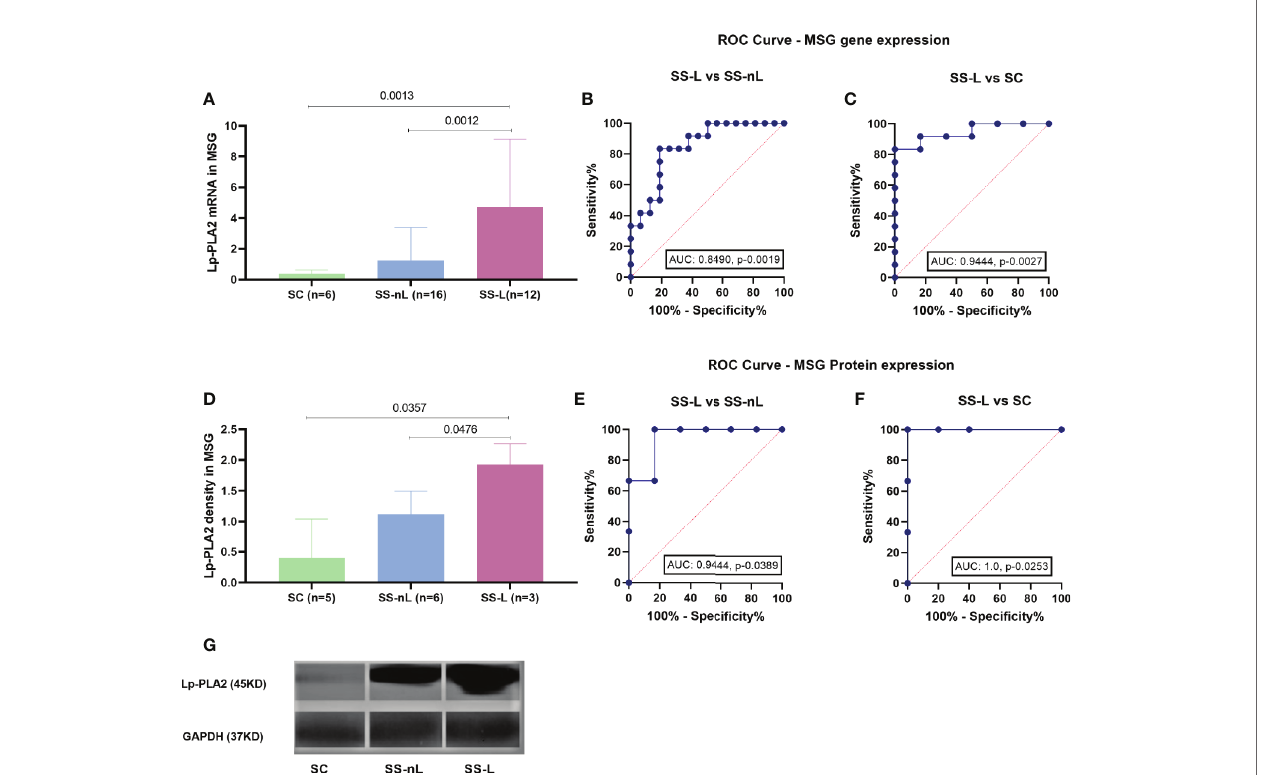
FIGURE 2 | Lp-PLA2 (encoded by the PLA2G7 gene) mRNA expression (measured by real-time PCR) and protein density (tested by Western blot) in MSG tissues of our study participants and ROC curve analysis for both methods. (A) PLA2G7 gene expression was signi fi cantly increased in SS-L patients compared to both SS- nL patients and SC (p-values: 0.0012 and 0.0013, respectively). (B) ROC analysis could distinguish between SS-L and SS-nL patients with an AUC 0.8490, CI (95%): 0.71 – 0.99, p-value: 0.0019. (C) For SS-nL vs SC patients ROC curves showed an AUC 0.9444, CI (95%): 0.84 – 1.00, p- value: 0.0027. (D) Increased Lp- PLA2 protein expression was found in MSG total protein extracts derived from SS-L patients compared to both SS-nL patients and SC as tested by Western Blot (p-values: 0.0476 and 0.0357, respectively). (E) ROC analysis for Lp-PLA2 protein expression depicted an AUC of 0.94, CI (95%): 0.79 – 1.00, p-value: 0.0389 for SS-L vs SS-nL patients. (F) ROC analysis revealed an AUC of 1.00, CI (95%): 1.00 – 1.00, p-value: 0.0253. (G) Representative image of Lp-PLA2 and GAPDH MSG protein expression by Western Blot. SC, controls with sicca complaints; SS-n, Sjogren ’ s syndrome; SS-L, Sjogren ’ s syndrome complicated by lymphoma; ROC, receiver operating characteristic; AUC, area under the